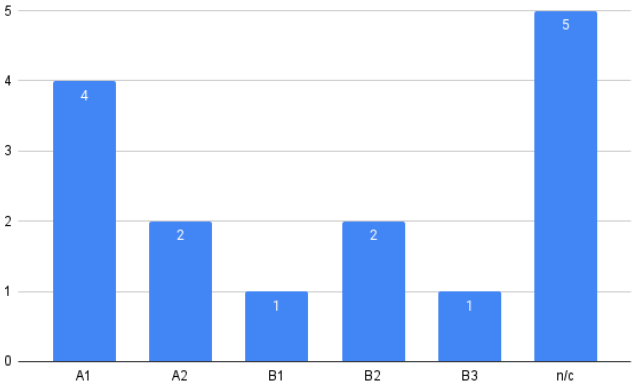
Figure 18. Conferences according to their